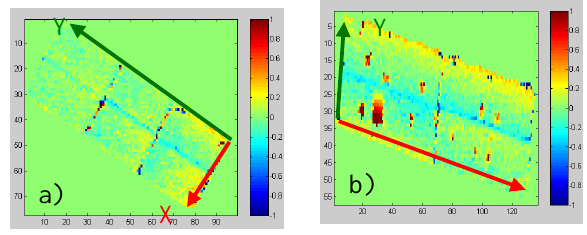
Figure 10. Error map visualisation; a) and b) Buildings 3 and 6 The pixel values in this matrix are equal to the deviation ones.